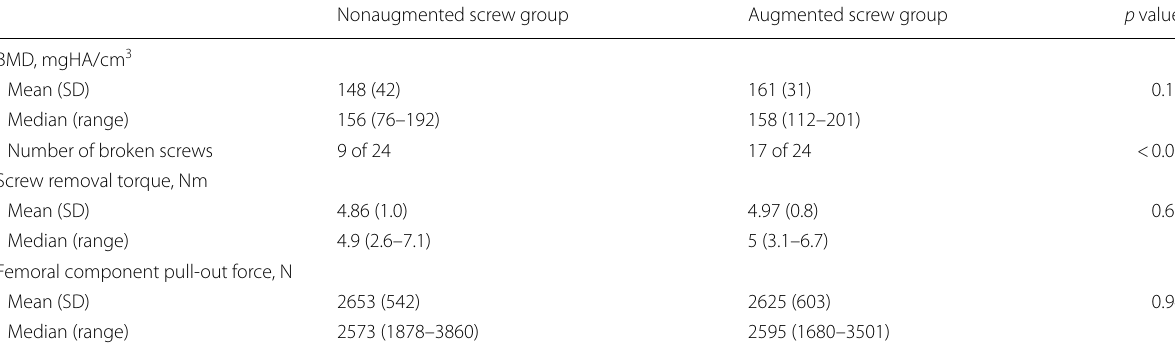
p value based on # the paired-samples t test or * Fisher’s exact